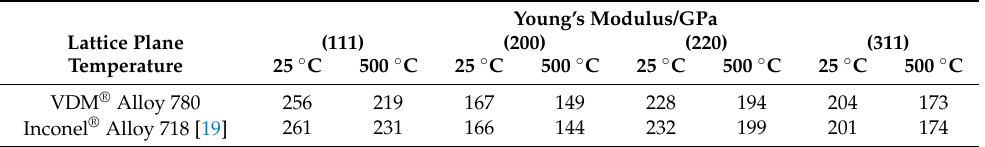
Table 4. Elastic constants of the individual lattice planes. As a comparison, the literature data for Alloy 718 [19] are also